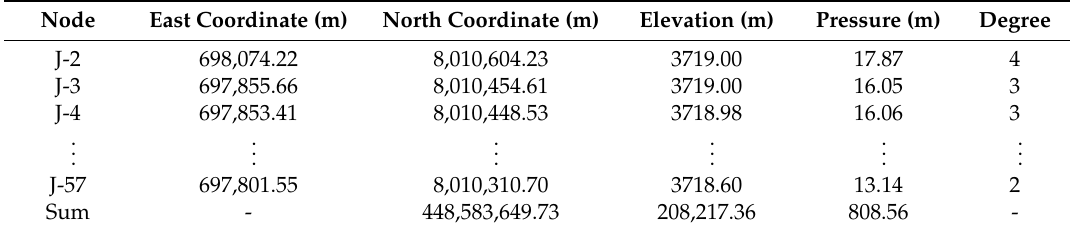
Table 3. Criteria for clustering process.